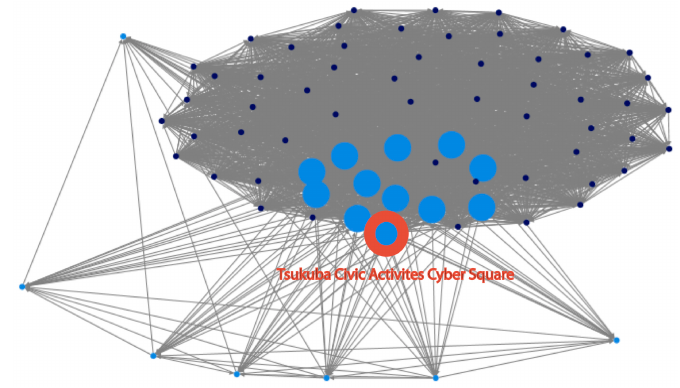
Figure 2. Node XL analysis result map of neighborhood associations (12 June 2015).